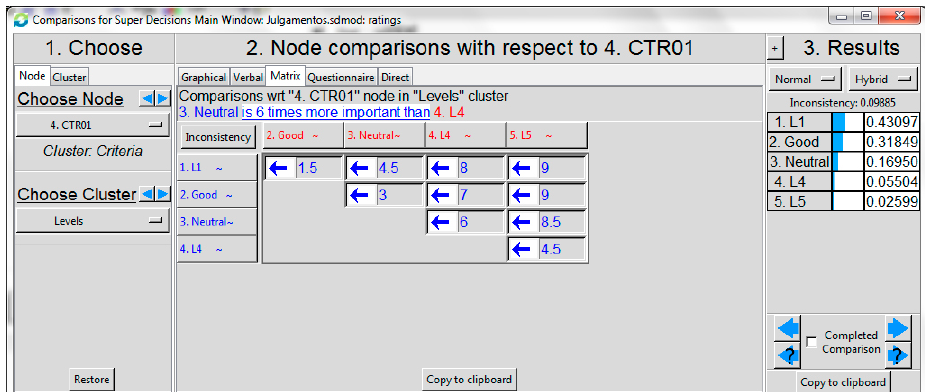
fig. 4. Judgments and value scale of the ctr